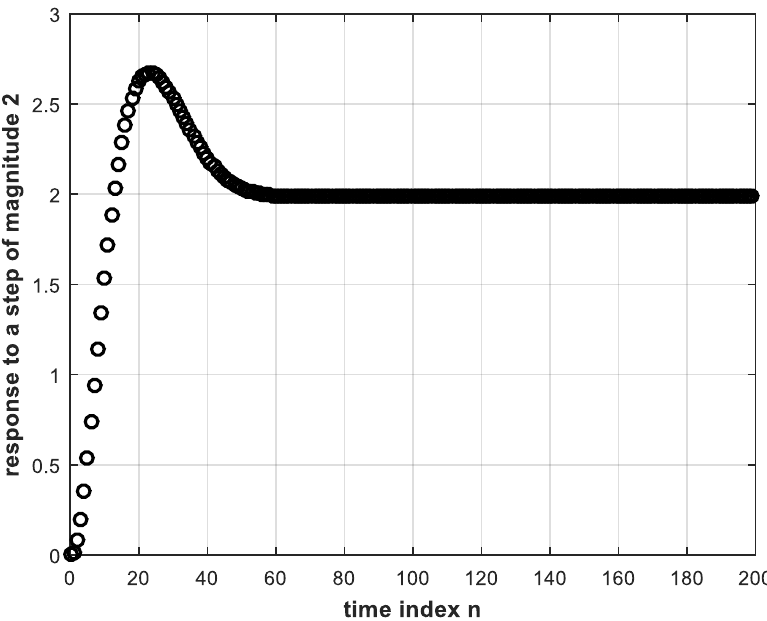
Figure 8. System response to a step magnitude of 2 using the trained DL controller.